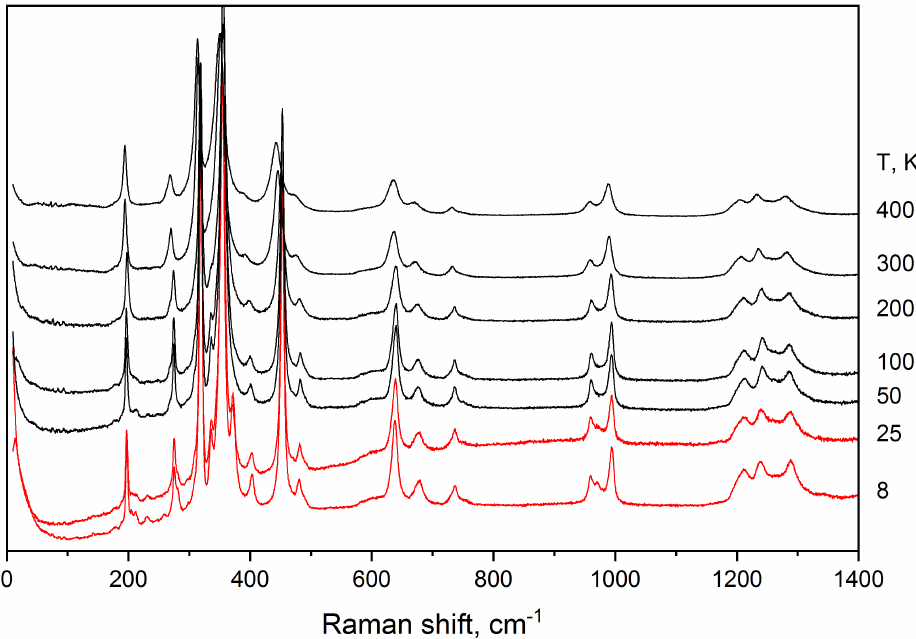
Figure 1. Full Raman spectra transformation with temperature of TbFe 2.46 Ga 0.54 (BO 3 ) 4 . Color code: black— R 32 phase, red— P 3 1 21